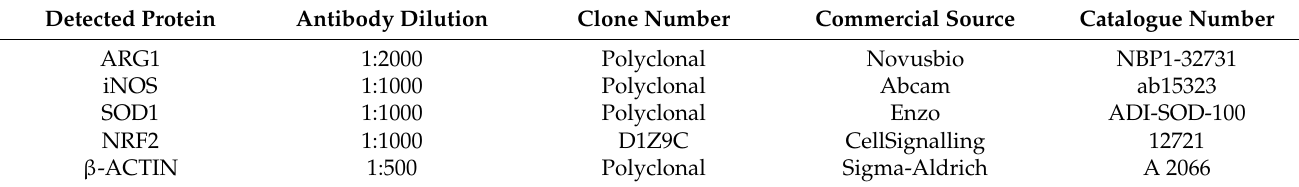
Table 2. Antibodies used for